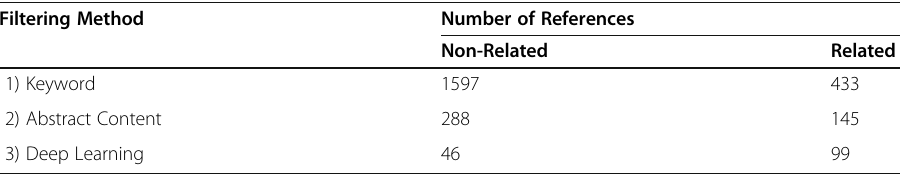
Table 2 Procedure for filtering out non-related